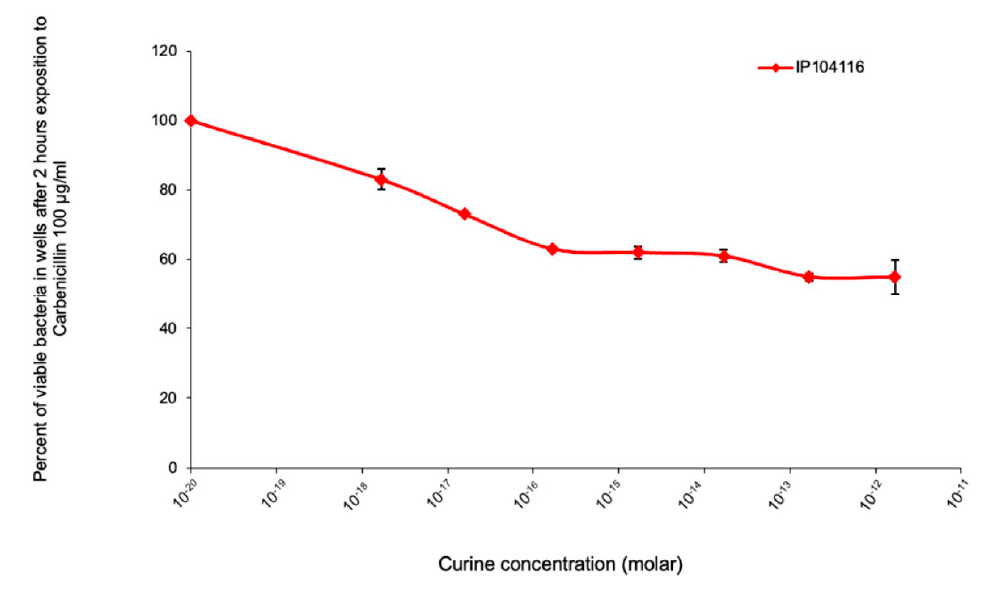
Figure 4. Effects of curine on the sensitivity of P. aeruginosa (IP104116) to carbenicillin. A total of 50 µL of LB in the presence or absence of 200 µg/mL of carbenicillin and increasing concentrations of curine was added to 50 µL of LB containing about 2 × 10 5 bacteria in a 96-well plate. After two hours of incubation at 37 °C, viable bacteria were numbered by plating the adequate dilution on LB agar plates. The percentage of viable bacteria was calculated and plotted as a function of the curine concentration. The results presented in this figure are the mean values of three independent experiments. Curves presenting the variation in IC50 in the presence of the alkaloids obtained for the two strains of P. aeruginosa for each antibiotic had the same shape. For a simplified analysis, a calculation of the average value of the IC50 at the plateau was performed, and the results are presented in Tables 1 and 2. Table 1. IC50 of P. aeruginosa IP104116 for carbenicillin, novobiocin, and erythromycin in the presence or absence of alkaloids.